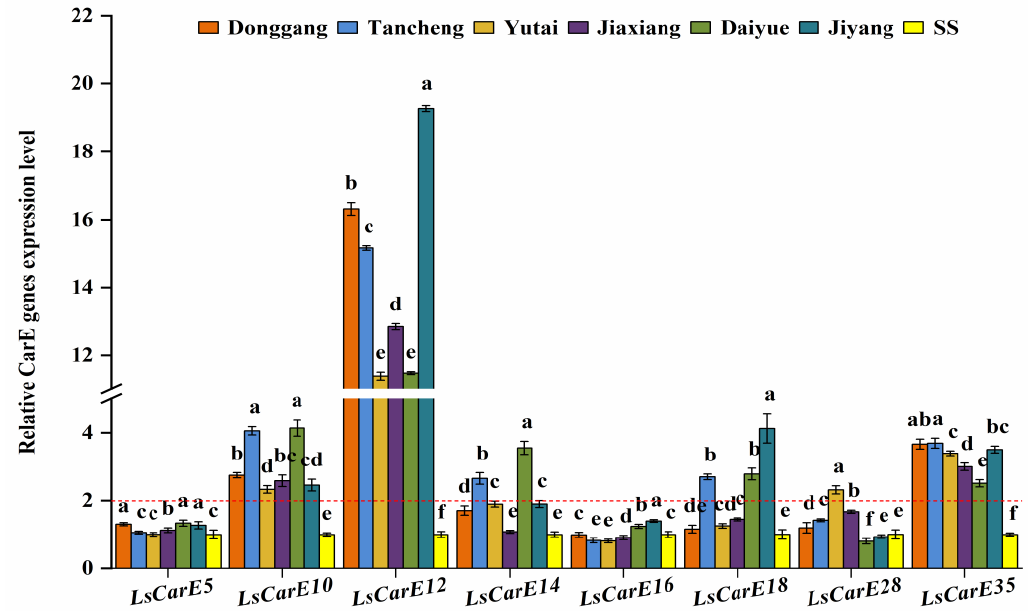
Figure 3. The relative expression levels of eight CarE genes in six L. striatellus populations from Shandong Province compared with SS (red dotted line means 2-fold overexpression level). The data are the mean ± SE ( n = 3), and different letters on the bars indicate significant differences ( p < 0.05). The relative expression levels of eight GST genes in all the field populations did not change much (Figure 4). Compared with SS, only two GST genes ( LsGSTd1 and LsGSTo1 )